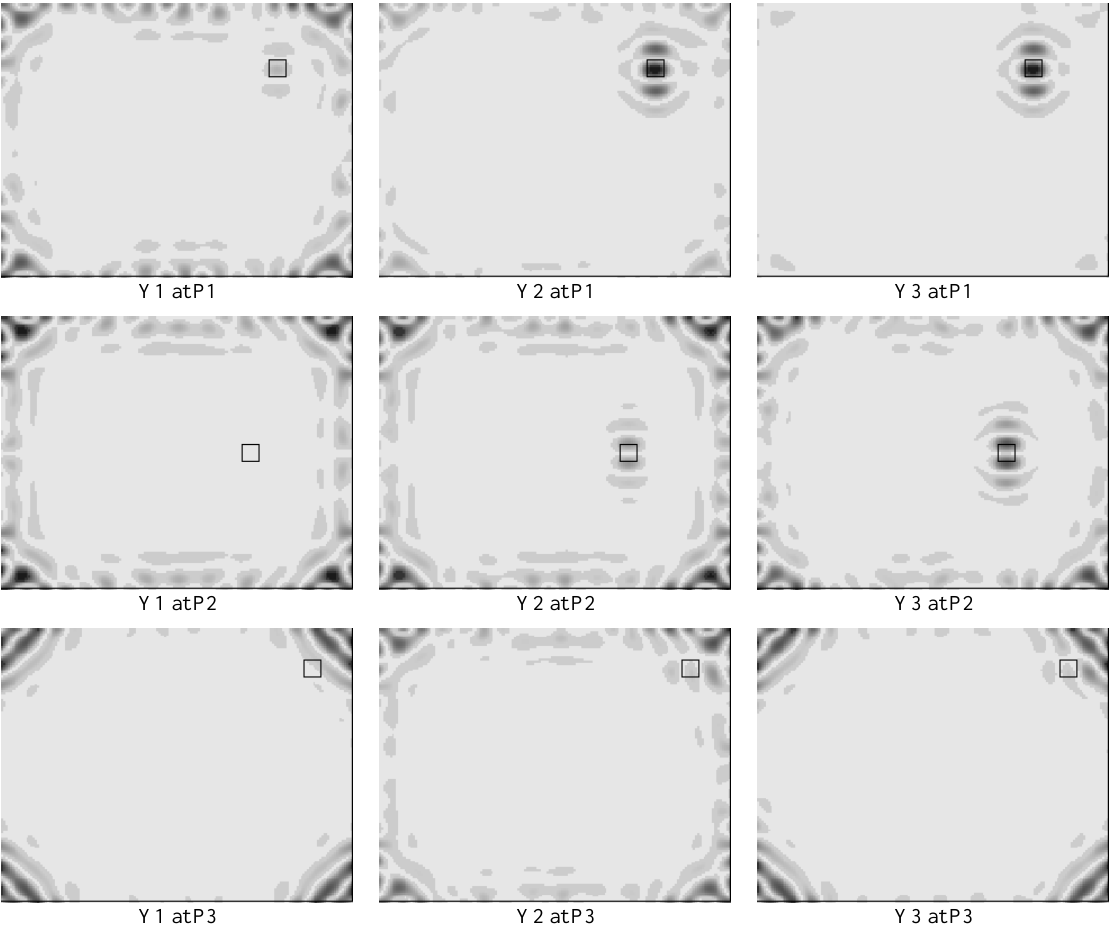
Fig. 7. Damage index D 2 for Y1, Y2 and Y3 damages at P1, P2 and P3